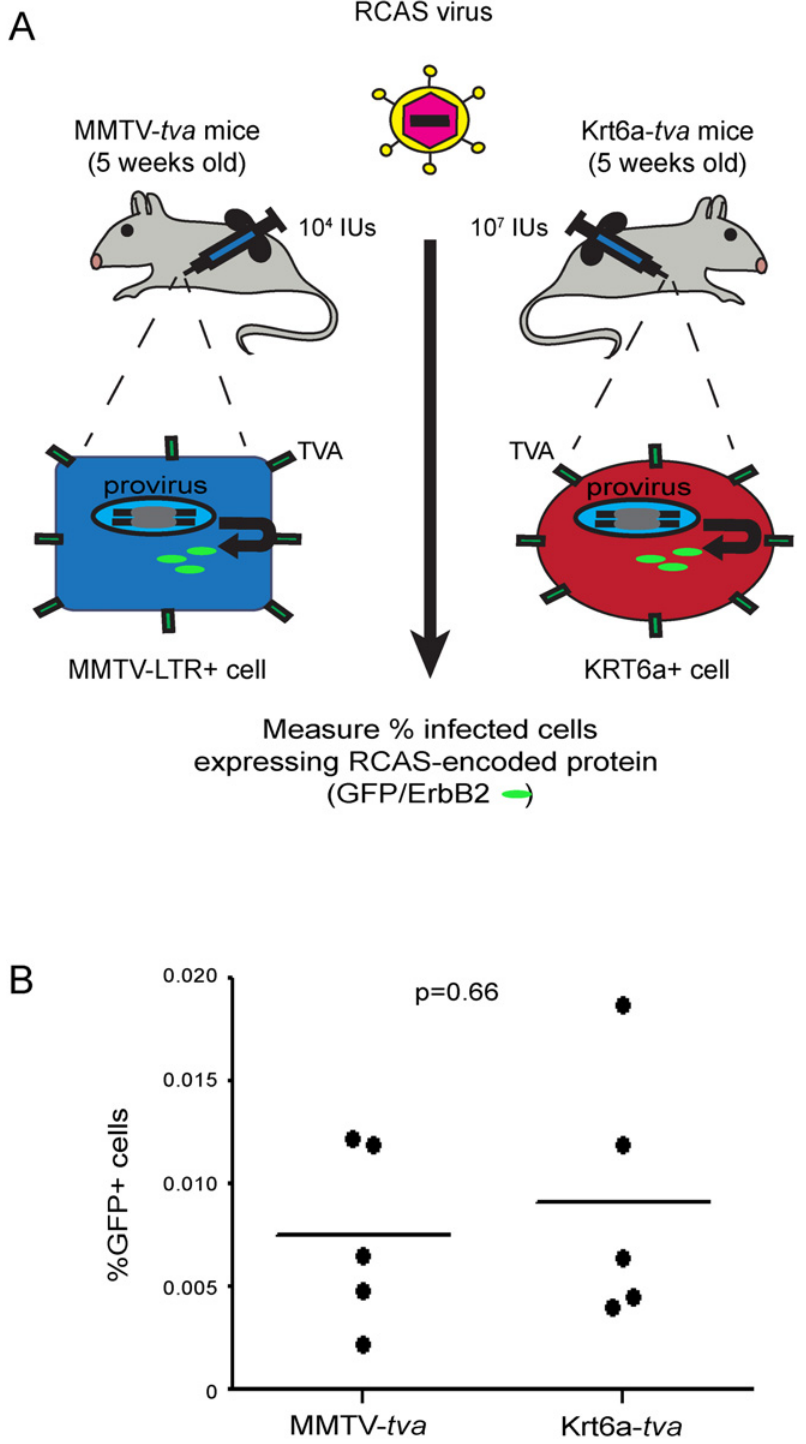
Fig 1. Infection rates are similar between MMTV- tva mice and and K6a- tva mice after viral dosage adjustment. (A) 10 4 and 10 7 IUs of RCAS- GFP was intraductally injected into the mammary glands of MMTVA- tva and K6a- tva mice (n = 5). Injected mammary glands were collected 2.5 – 4 days post-injection to quantify TVA+ cells via flow cytometry. (B) The percentage of RCAS- GFP -infected cells from K6a- tva mice (0.009%) was comparable with that from MMTV- tva (0.008%).